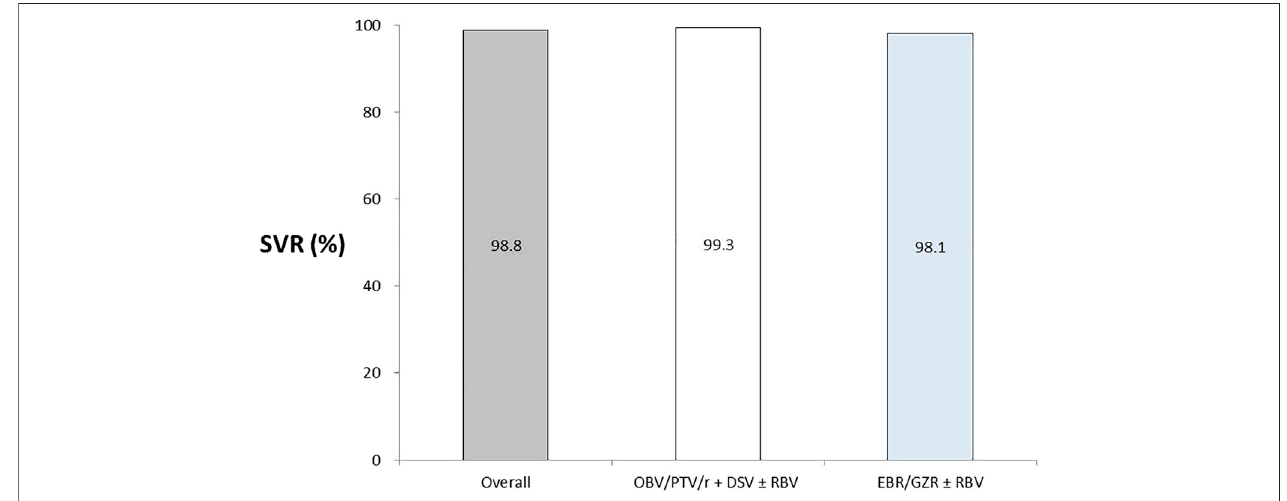
FIGURE 2 | Patients with HCV RNA